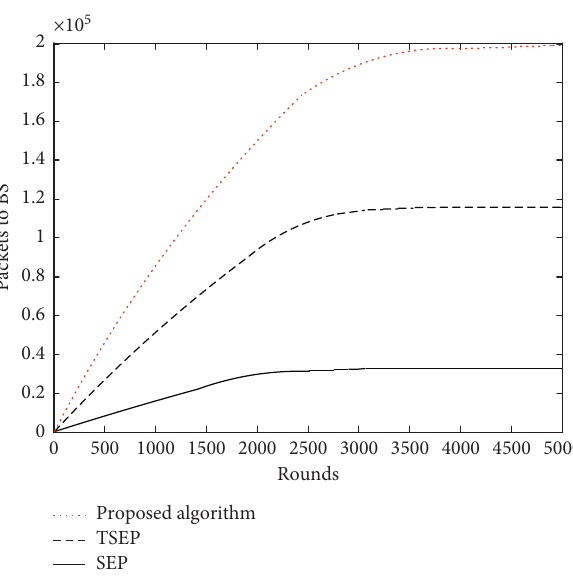
Figure 8: Throughput with a single